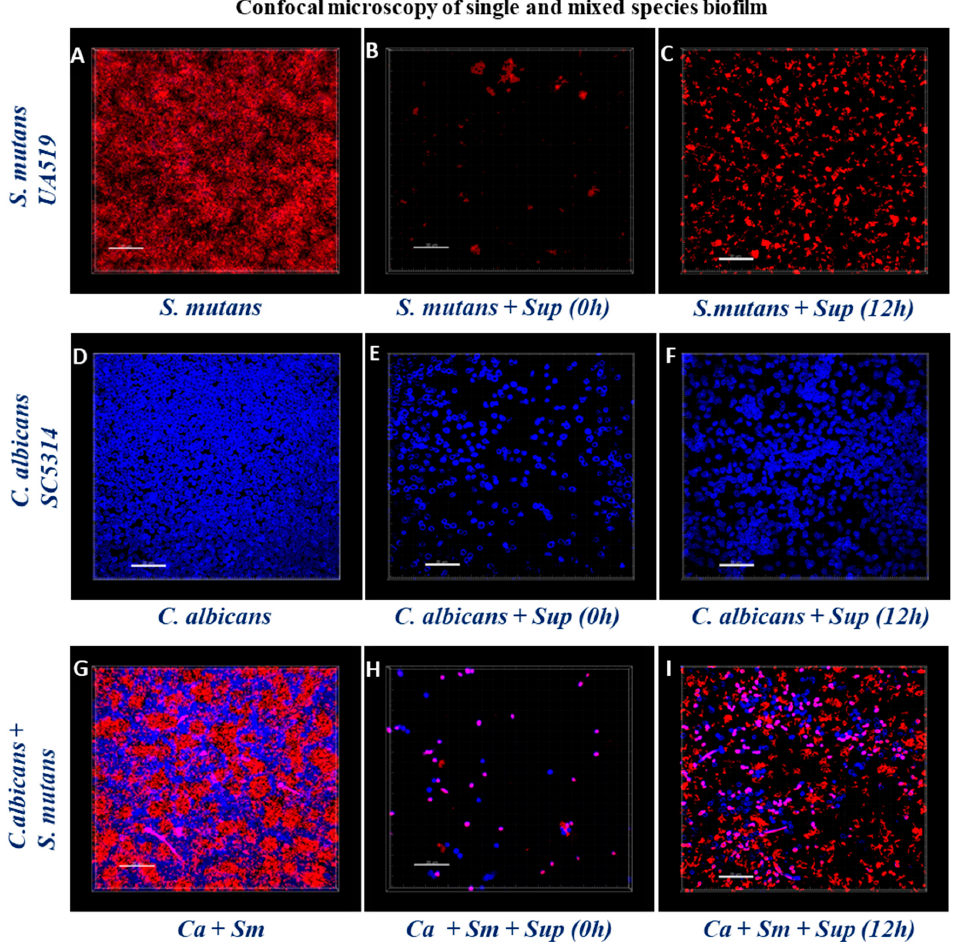
Figure 5. CLSM examination of S. mutans (Sm) and C. albicans (Ca) single and mixed-species biofilm formation in the presence of Lactobacillus plantarum 108 supernatant (Sup). The biofilms were fixed and stained with calcofluor white for C. albicans (in blue) and propidium iodide for S. mutans (in red).